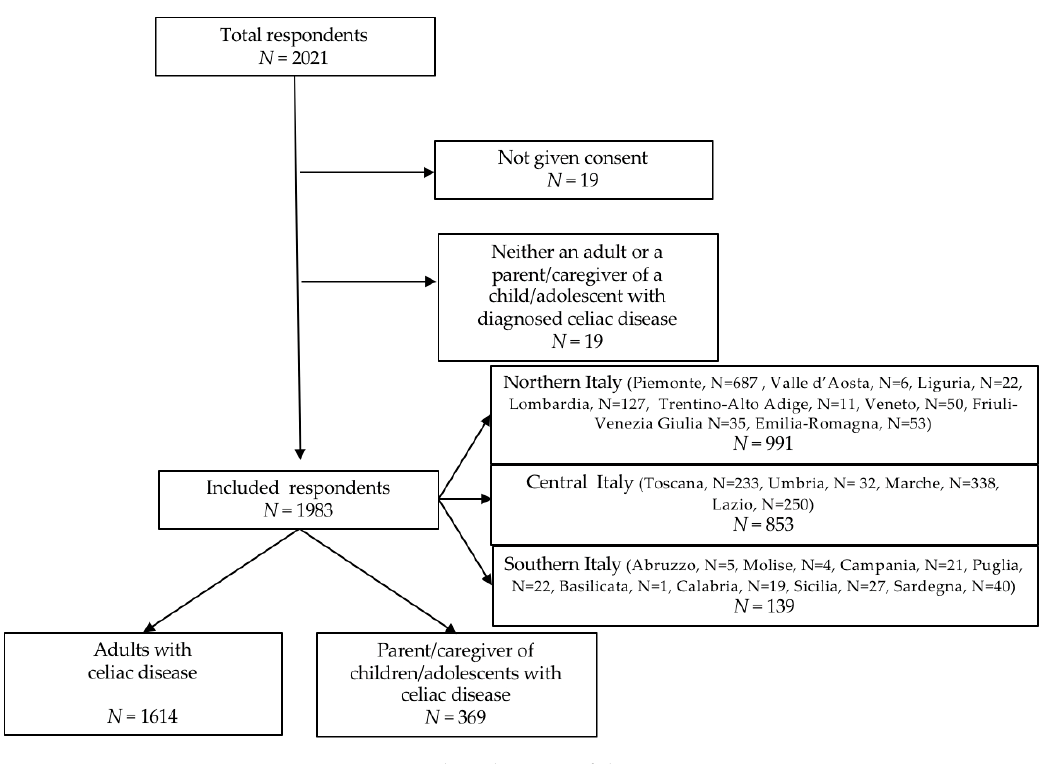
Figure 1. Flow diagram of the survey. Table 1. Socio-demographic characteristics, working and housing conditions of the